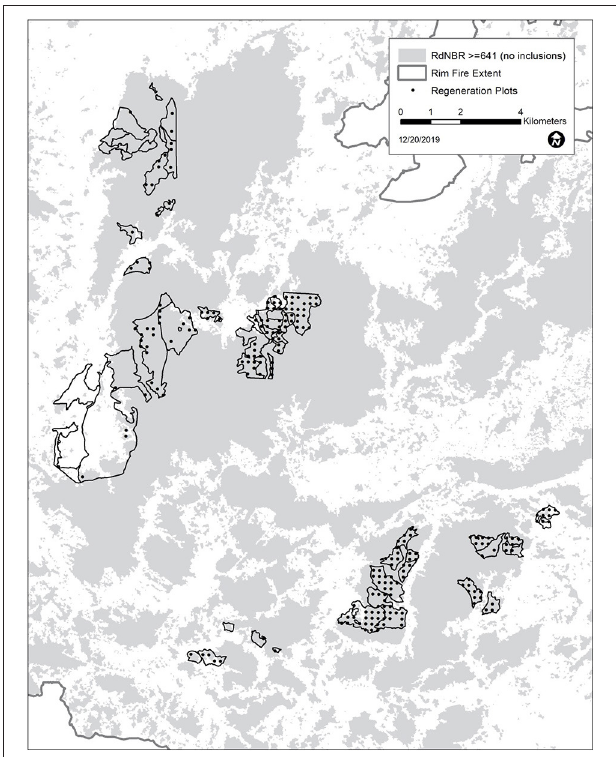
FIGURE 1 | Study area map of the high-severity fire areas (Relative differenced Normalized Burn Ratio [RdNBR] values > 641; Miller and Thode, 2007) and field plots surveyed, in 2018, for this study in the Rim